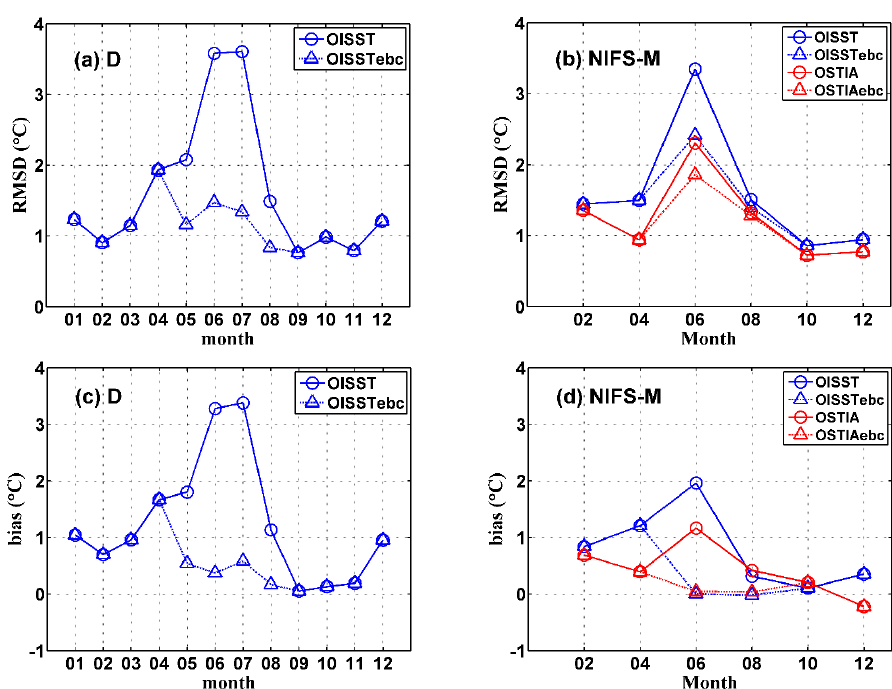
Figure 7. Seasonal variations in the monthly mean ( a , b ) SST RMSD and ( c , d ) bias (°C) between the in situ data (D and NIFS-M) and the gridded datasets (OISST and OSTIA) before and after applying the first bias correction method using the analytical (exponential and cosine) functions. The circles represent the original SST data and triangle represents the bias corrected data.